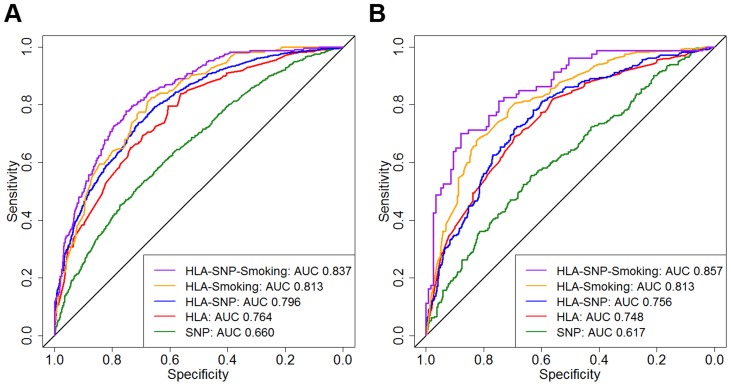
Prediction model receiver operating characteristic curves.Panel A = WTCCC; Panel B = UKRAGG; ROCs calculated for discriminating between ACPA-positive RA and controls; AUC = area under the curve. WTCCC model AUC comparisons: SNP versus HLA, P<0.0001; HLA versus HLA-SNP, P = 0.0118; HLA-SNP versus HLA-Smoking, P = 0.3327; HLA-Smoking versus HLA-SNP-Smoking, P = 0.0001. UKRAGG model AUC comparisons: SNP versus HLA, P<0.0001; HLA versus HLA-SNP, P = 0.665; HLA-SNP versus HLA-Smoking, P = 0.0145; HLA-Smoking versus HLA-SNP-Smoking, P = 0.1671.